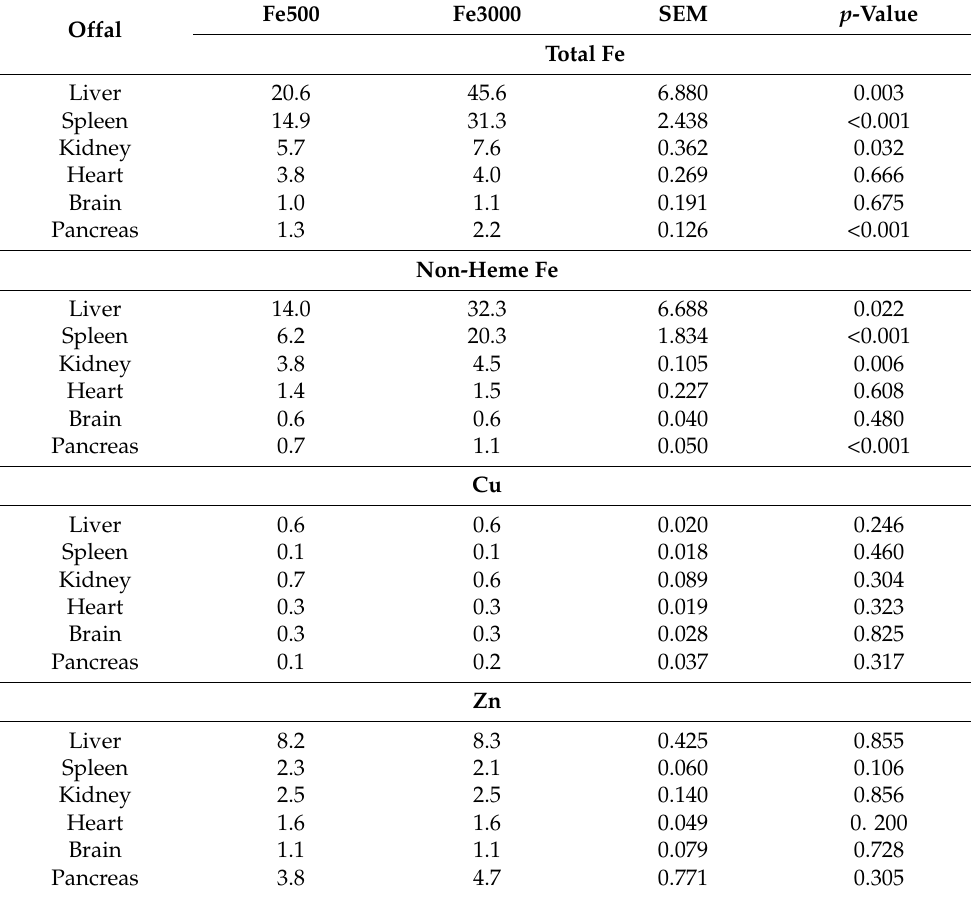
Table 5. Effect of oral iron (Fe) supplementation on total Fe, non-heme Fe, copper (Cu), and zinc (Zn) concentrations in pork offal (mg/100